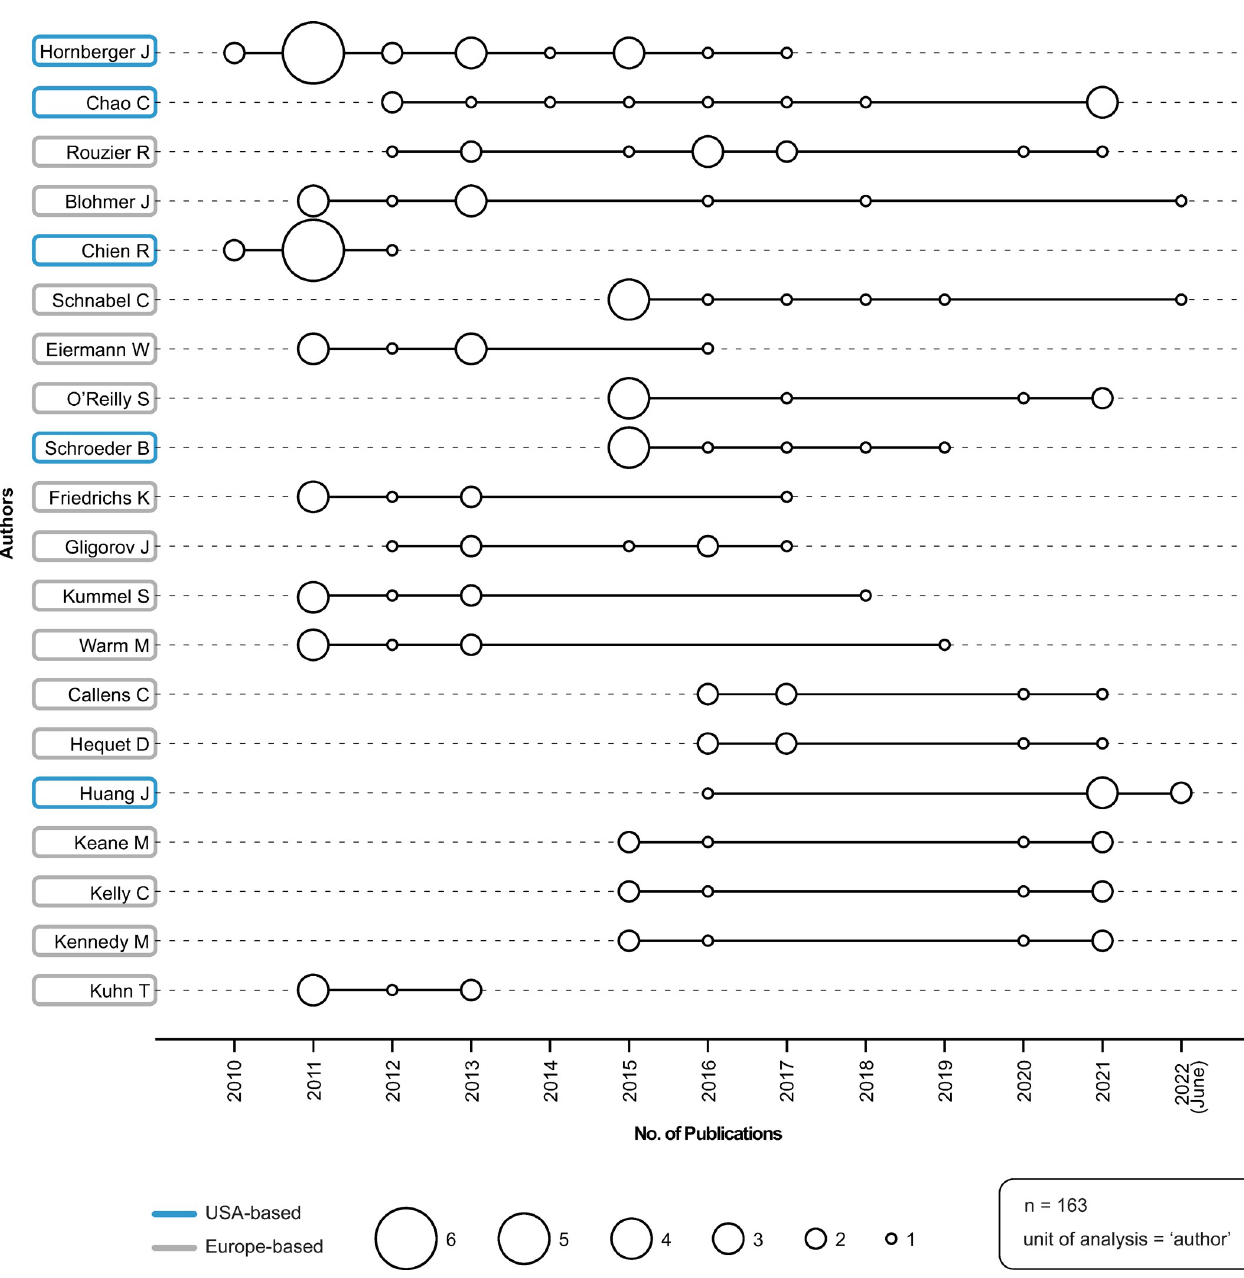
20 affiliates were industry-related (red ring)—and these were all based in the USA. Of note, the combination of Genomic Health and Exact Sciences (Genomic Health was purchased by Exact Sciences in 2019 [42]), would constitute the top industry affiliate (n = 20). The remaining 14 affiliates were medical- or academic-related (gray ring). Of these, six were based in Germany, three in France, two in USA, two in Ireland, and one in Israel.